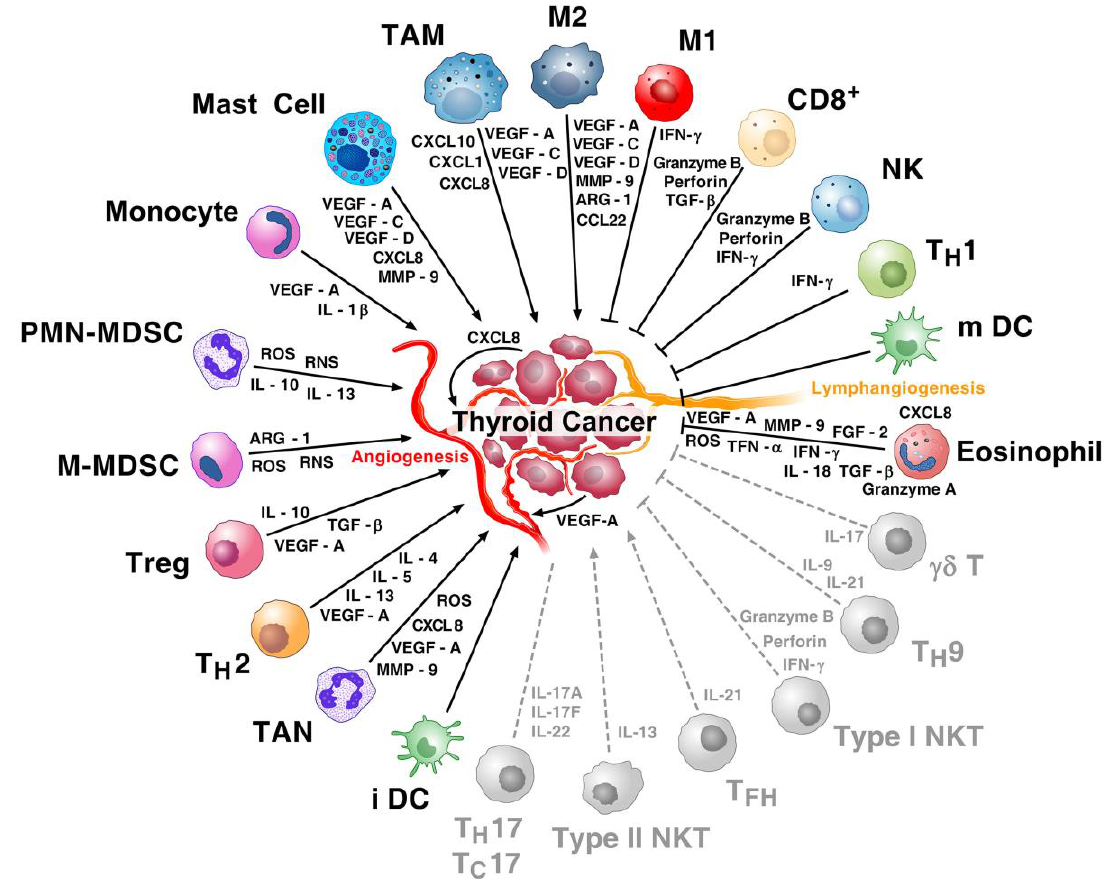
Figure 1. Hypothetical scheme of immune contexture of thyroid cancer (TC). The immune network in thyroid cancer is a complex and dynamic system characterized by multiple interactions between tumor cells and nearly all immune cells. Tumor-associated macrophages (TAM), M2 macrophages, tumor-associated mast cells, monocytes, polymorphonuclear-myeloid-derived suppressor cells (PMN-MDSCs), monocyte-derived suppressor cells (M-MDSCs), T regulatory cells (Treg) and T helper 2 (Th2) cells, tumor-associated neutrophils (TAN), and immature DCs (iDCs) and their mediators play protumorigenic roles in thyroid cancer. M1 macrophages, cytotoxic CD8 + T cells, natural killer (NK) cells, Th1 cells, mature DCs (mDCs), and their mediators play an antitumorigenic role. There is increasing evidence that eosinophils play an antitumorigenic role in different cancers [102,108,109]. VEGF-A and CXCL8 produced by thyroid cancer cells activate tumor angiogenesis. Mast cells and macrophages are major producers of lymphangiogenic factors (VEGF-C and VEGF-D). The a ntitumorigenic role of γδ T cells, Th9 cells, and type I natural killer T (NKT) cells (grey and dashed lines) have been demonstrated in several other human cancers. The protumorigenic role of Tfh cells and of type II NKT cells has been shown in several other human tumors (grey and dashed lines). Protumor or antitumor activities of Th17 and Tc17 cells are context-dependent (grey and dashed line). Modified with permission from Galdiero et al. [110].